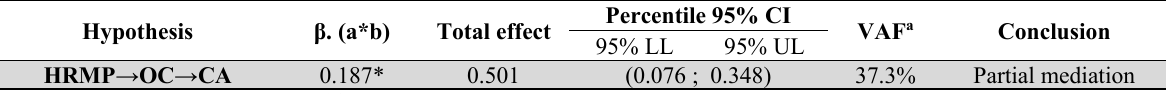
Mediating effects